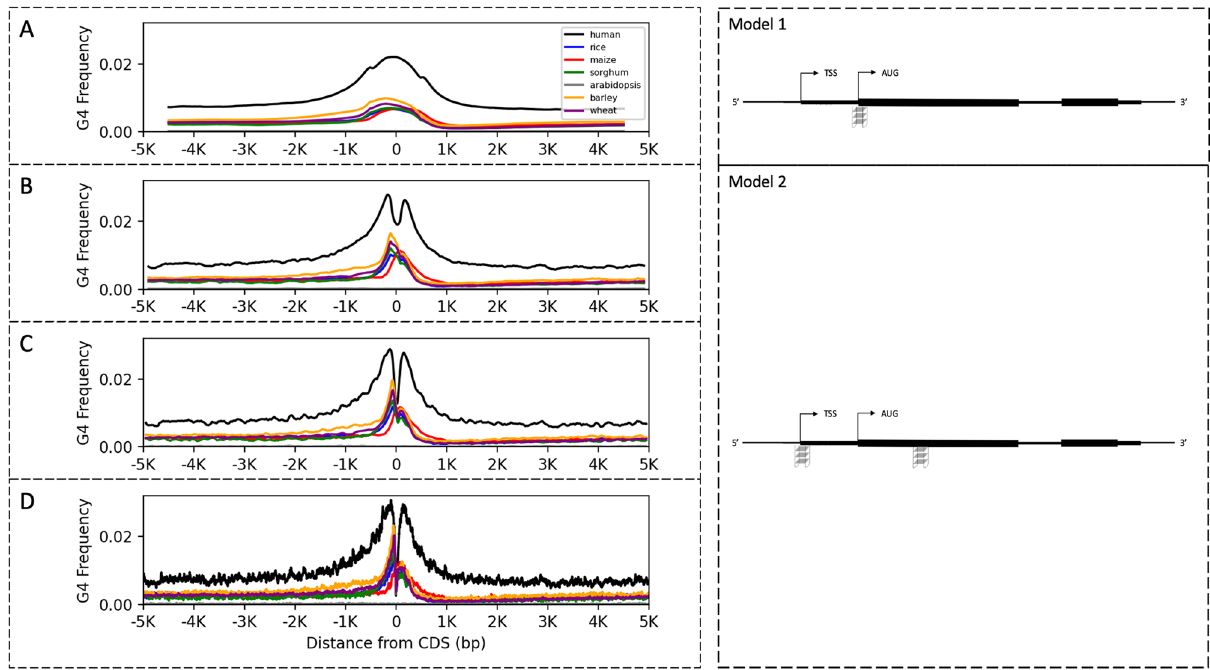
Figure 3. G4 motif frequency per Mb over 10,000 bp region centered at the first CDS start site. Moving averages were calculated with a window size of ( A ) 999 bp, ( B ) 199 bp, ( C ) 99 bp, and ( D ) 1 bp. Genomes colored as black for human, blue for rice, red for maize, green for sorghum, gray for Arabidopsis, orange for barley, and purple for wheat. On the right, predicted G4 motif distributions over genic regions are shown based on the corresponding abundance profiles of the plots on the left. Arrows illustrated the direction of transcription. CDS regions are shown as black boxes, UTR regions as the flanking regions from the gene ends, and the introns as the regions connecting CDSs. Model 1 is a prediction based on the G4 frequency graph averaged out with a window size of 1000 bp with a single peak and Model 2 is with a window size of 100 bp with a double peak. Inverted G4 structures indicate motifs on the antisense strand.